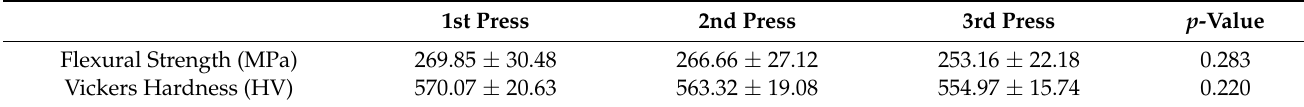
Table 1. Flexural strength and Vickers hardness mean values ( ±